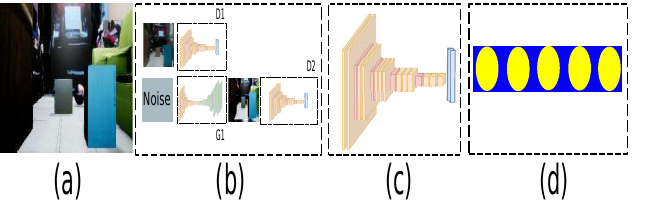
Figure 18. Path generator with the change of the domain. ( a ) Input sample. ( b ) Domain change. ( c ) Feature extraction network. ( d ) Generative path network.